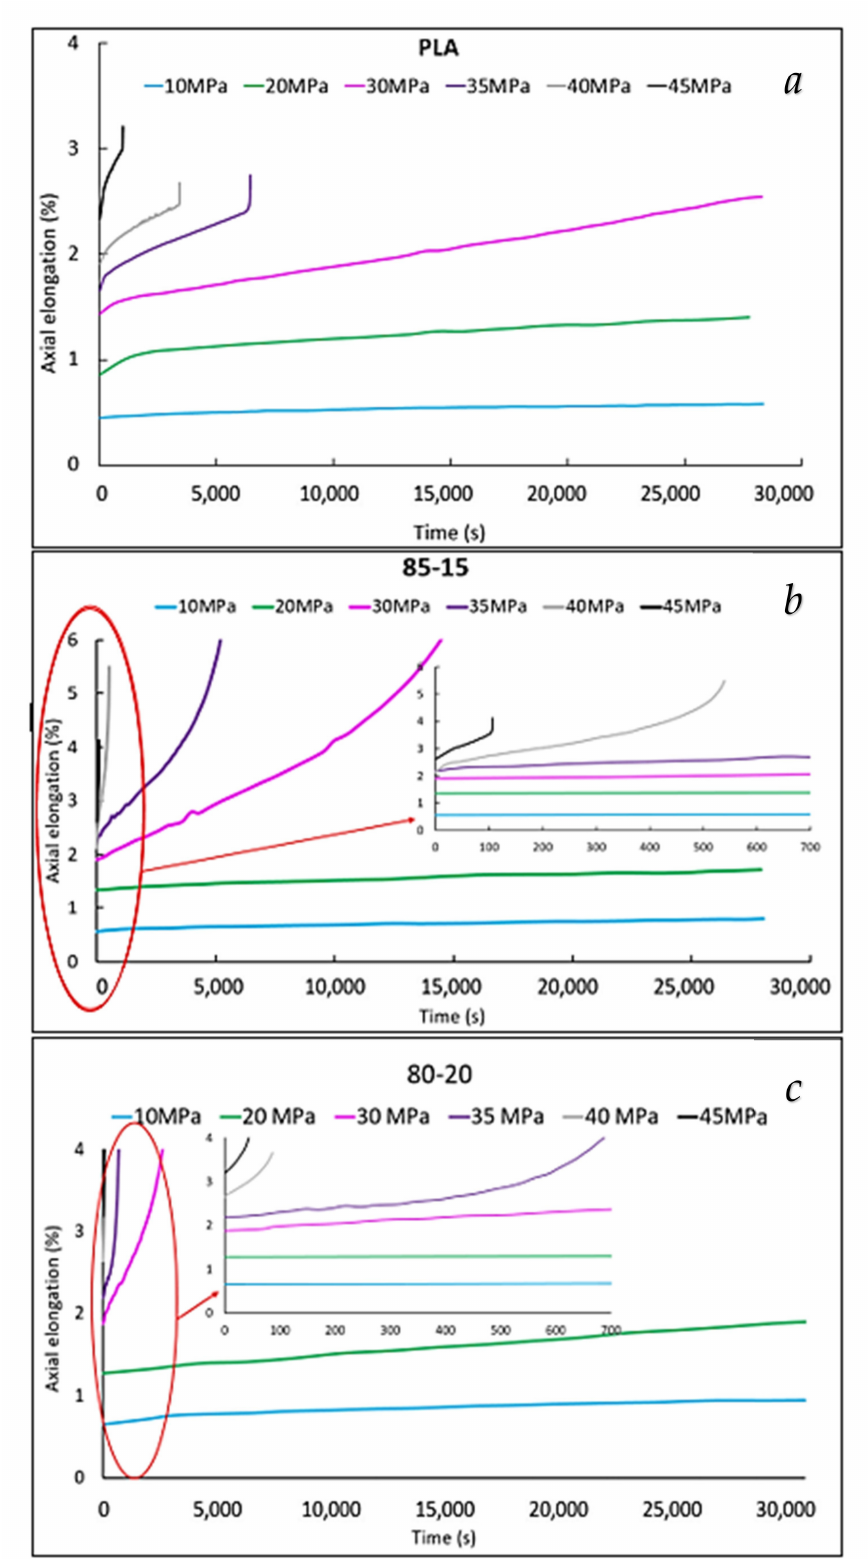
Figure 2. Axial elongation vs. time (creep curves) curves of pure PLA ( a ), 85-15 ( b ), and 80-20 ( c ) for different applied stresses from 10 to 45